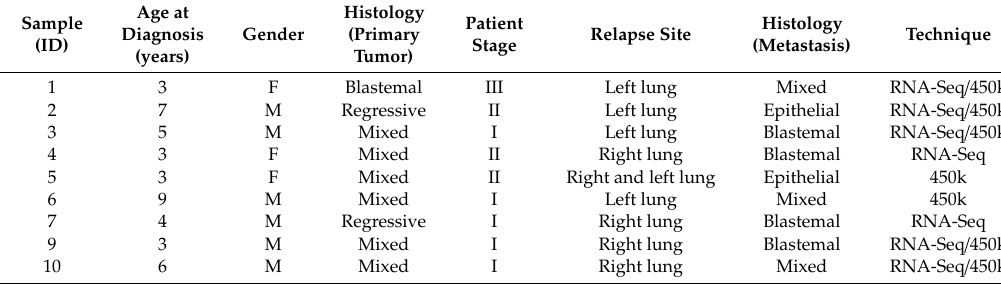
Table 1. Clinicopathological characteristics of the cases evaluated for DNA methylation and gene